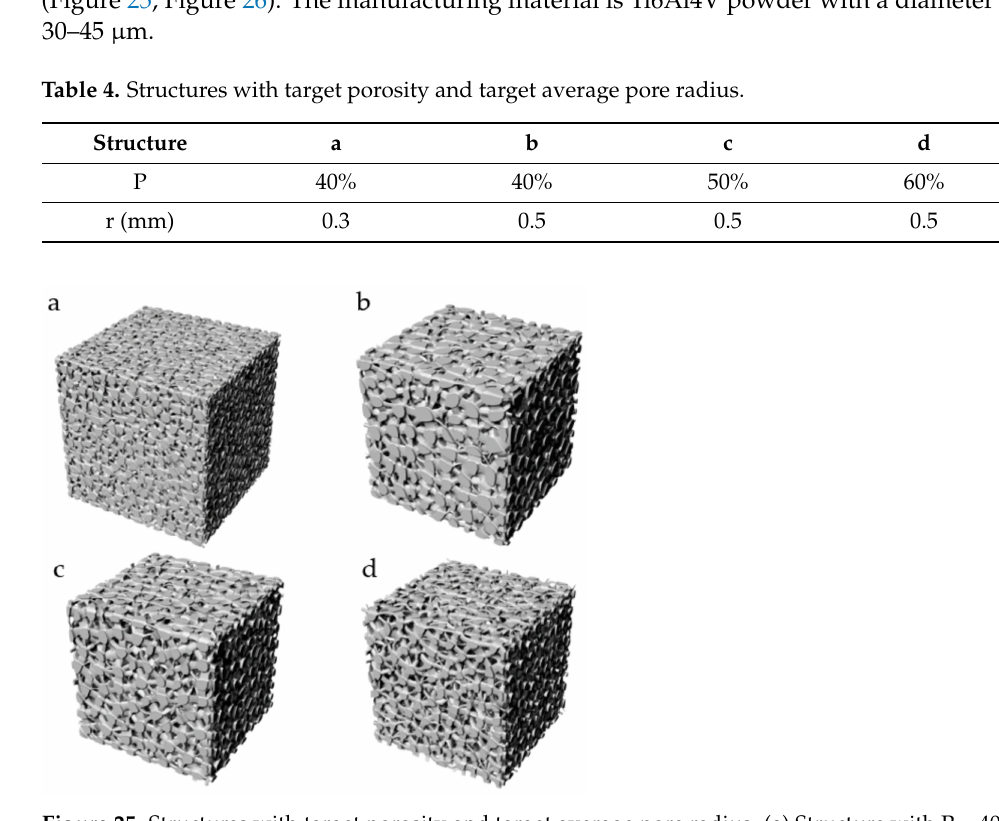
Figure 25. Structures with target porosity and target average pore radius. ( a ) Structure with P = 40%, r = 0.3 mm; ( b ) Structure with P = 40%, r = 0.5 mm; ( c ) Structure with P = 50%, r = 0.5 mm; ( d ) Structure with P = 60%, r = 0.5